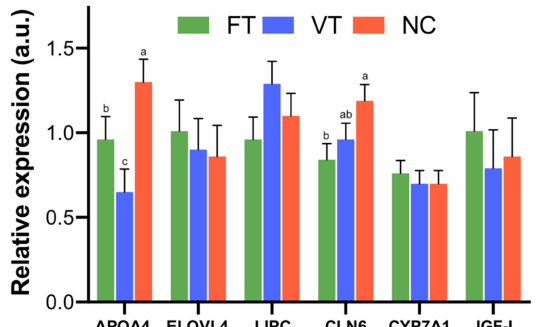
Figure 4. Relative expression of liver tissue was analysed using the six selected genes for RT-qPCR CR normalisation in o ff spring derived after embryo manipulation during the transfer procedure (FT, green), vitrified-transfer procedure (VT, blue) and nonmanipulated (NC, red). APOA4 : Apolipoprotein A-IV. ELOVL4 : Fatty Acid Elongase 4. LIPC : Lipase C. CLN6 : Transmembrane ER Protein. IGF-I : Insulin-like